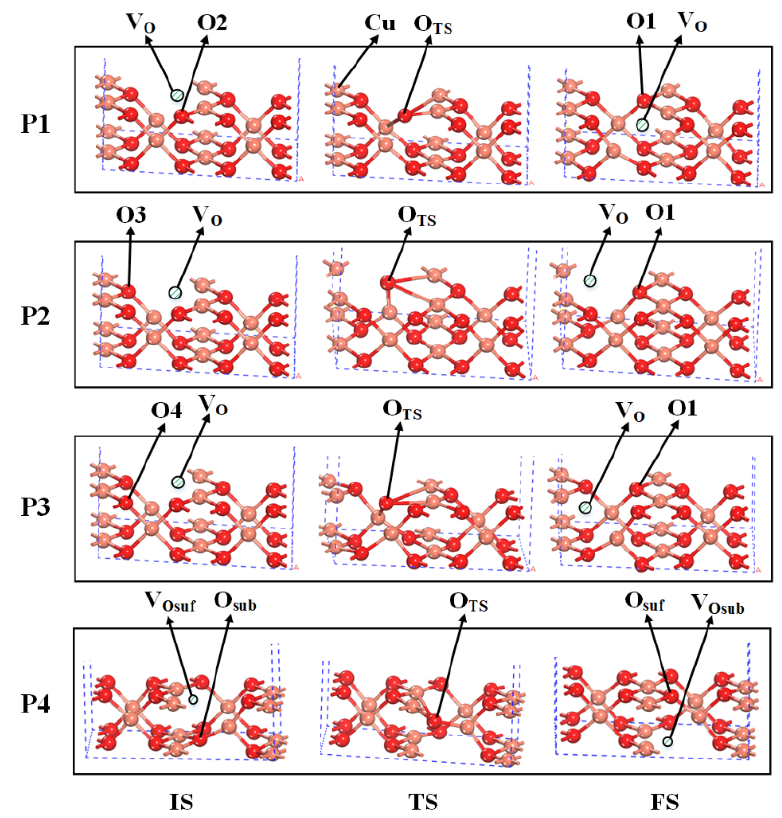
Figure 6. The initial state (IS), transition state (TS), and final state (FS) structures for the O anion diffusion processes in different pathways on the CuO(110) surface of O-terminated. The salmon pink and red spheres denote Cu and O atoms, respectively.